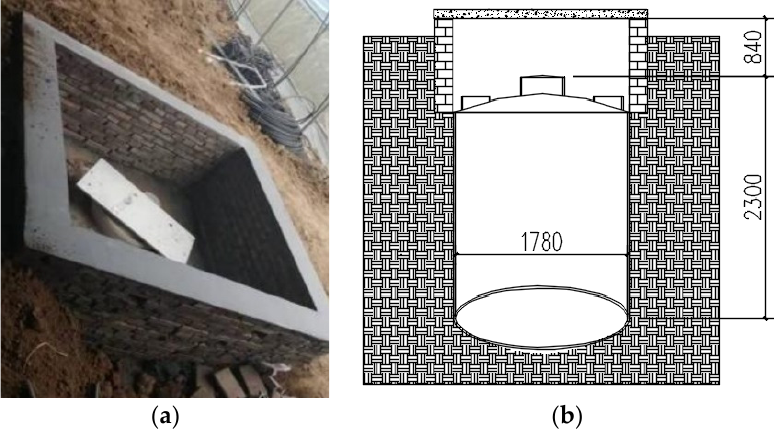
Figure 5. Structure of the buried water tank. ( a ) Water tank installation site and ( b ) Schematic diagram of tank size.